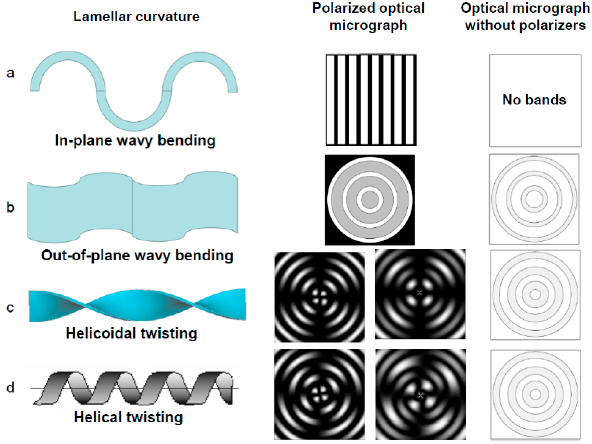
Figure 1. Organization scheme of curved lamellar crystals in thin film and the corresponding polarized optical micrographs: ( a ) In-plane wavy bending; ( b ) Out-of-plane wavy bending; ( c ) Helicoidal twisting; ( d ) Helical twisting of lamellar crystals and the corresponding pattern of optical micrograph. In ( c , d ), the second and third column corresponds to the simulated polarized optical micrograph of uniaxial and biaxial birefringent crystal, respectively. The simulated optical micrographs in the middle column of ( c , d ) are adapted from Ref. [14].